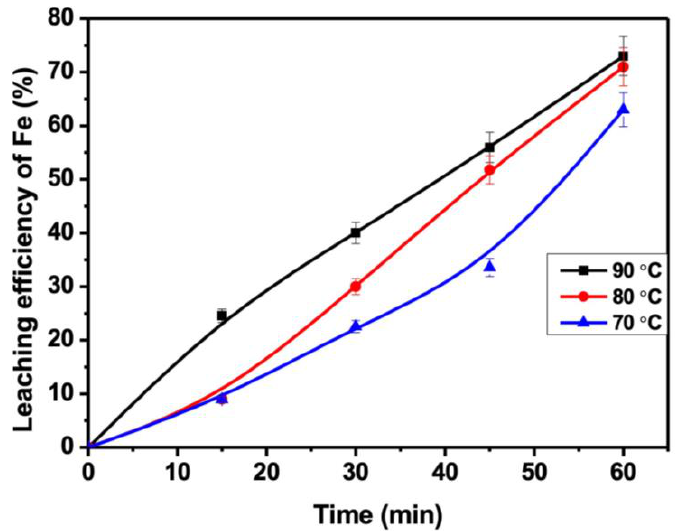
Figure 6. The effect of temperature on the leaching efficiency of Fe. Conditions: particle size, 150 µm; acid concentration, 7.5 M; solid–liquid ratio, 1:10; agitation speed, 350 rpm; agitation time, 60 min.